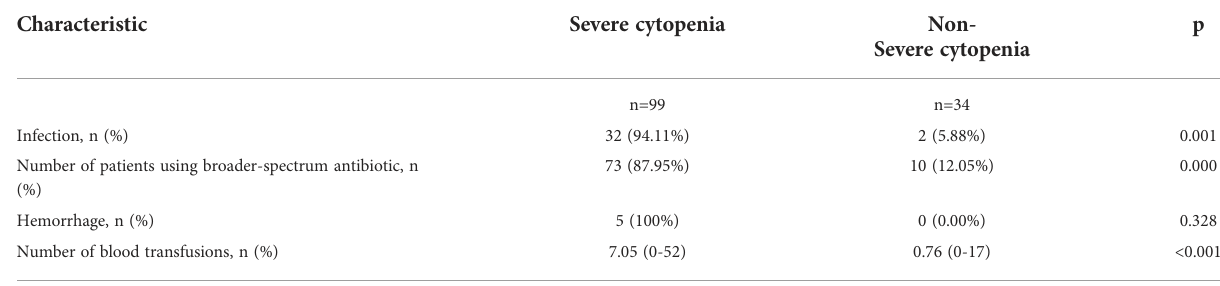
TABLE 2 Early severe hematological toxicities with cost of treatment and other adverse events after CAR-T-cell infusion.